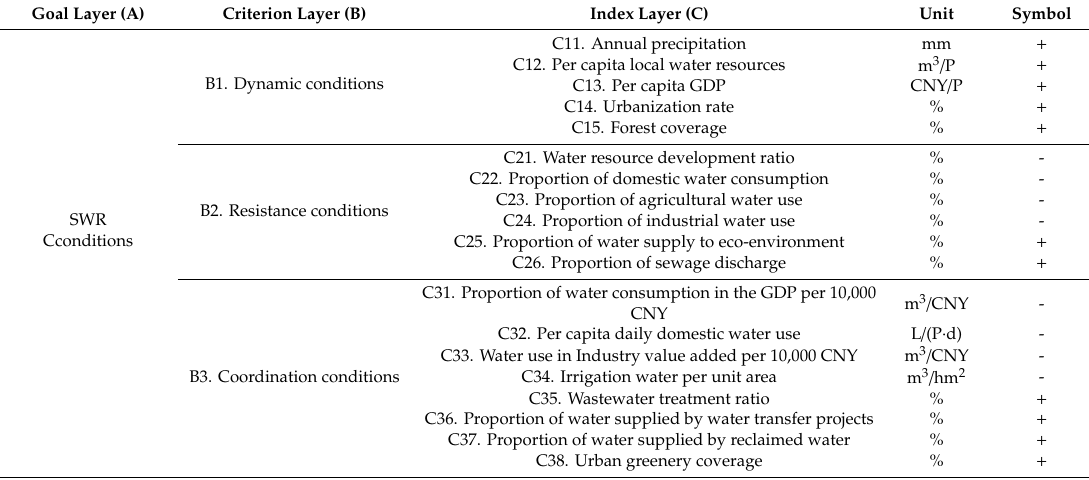
Table 2. Evaluation indicator system for the Beijing